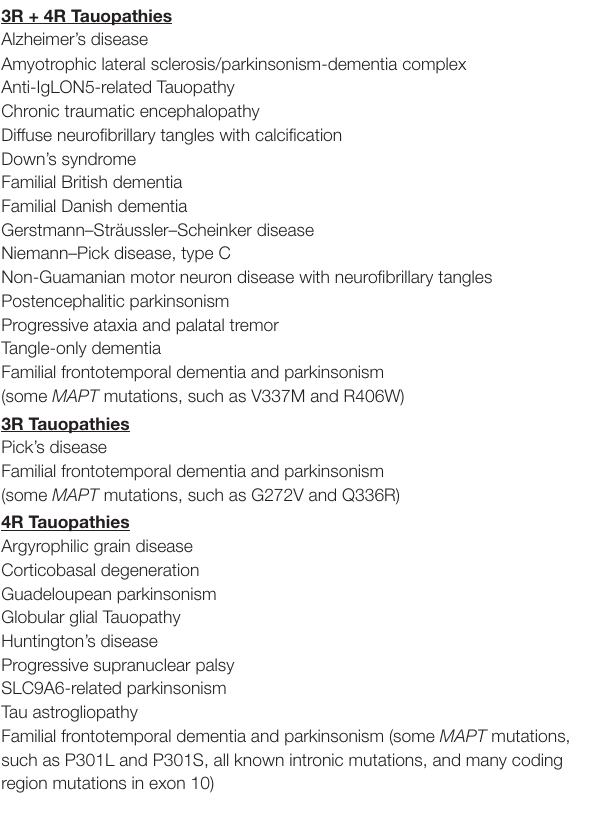
TABLe 1 | Neurodegenerative diseases with abundant tau